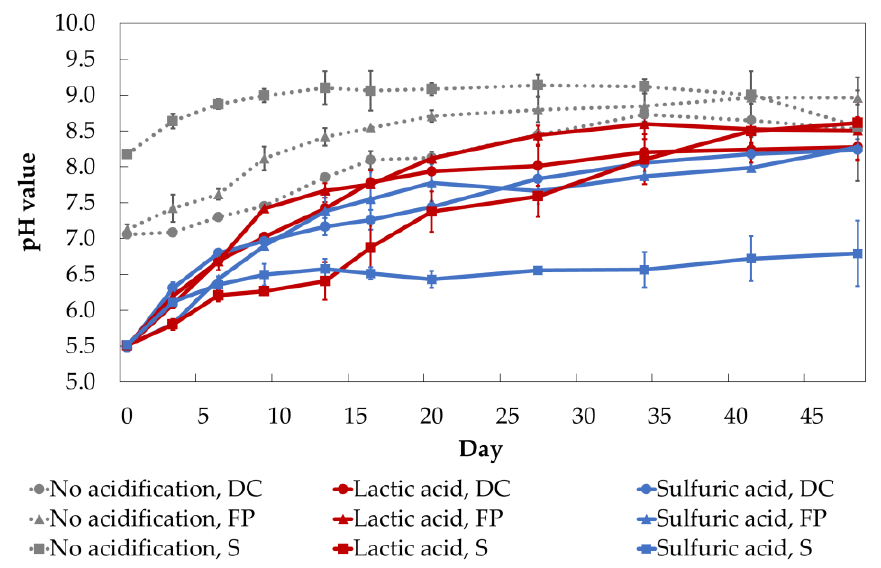
Figure 1. The pH value of dairy cow (DC, ●), fattening pig (FP, ▲ ), and sow (S, ■ ) slurry and after acidification with lactic or sulfuric acid to a pH value of 5.5 during the storage period of 48 days (means ± SD, n = 3).